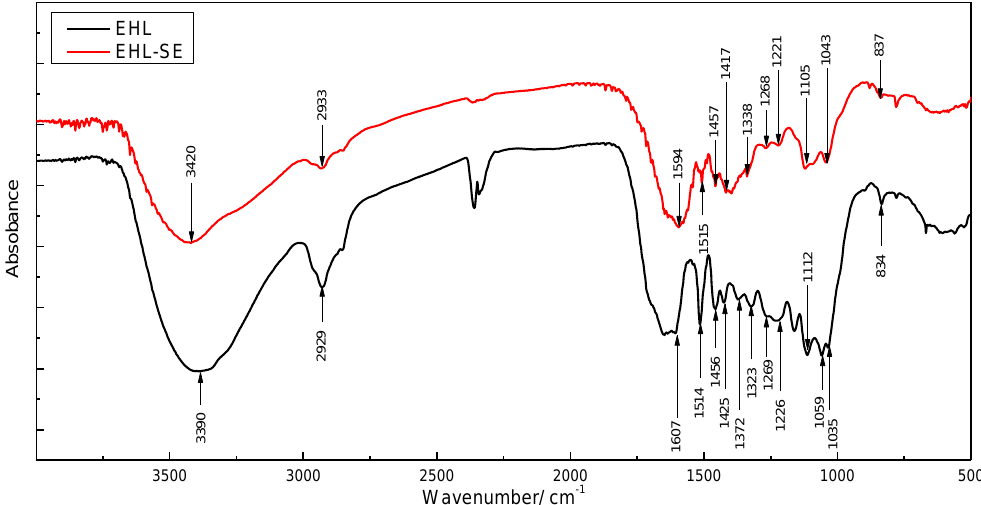
Figure 1. FTIR spectra of enzymatic hydrolysis lignin (EHL) and EHL treated with steam explosion (EHL-SE).